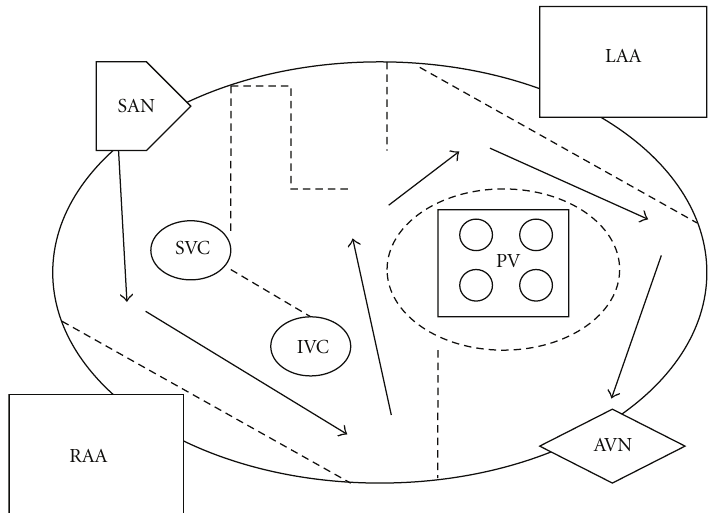
Figure 2: The Cox-Maze III lesion pattern described by James Cox in 1991 with cut and sew technique. Arrows show the direction of electrical current flow from the SA node to the atrioventricular node. (SN: SA node, PV: pulmonary veins, AVN: atriventricular node, SVC: superior vena cava, IVC: inferior vena cava, LAA: left atrial appendage, and RAA: right atrial appendage).